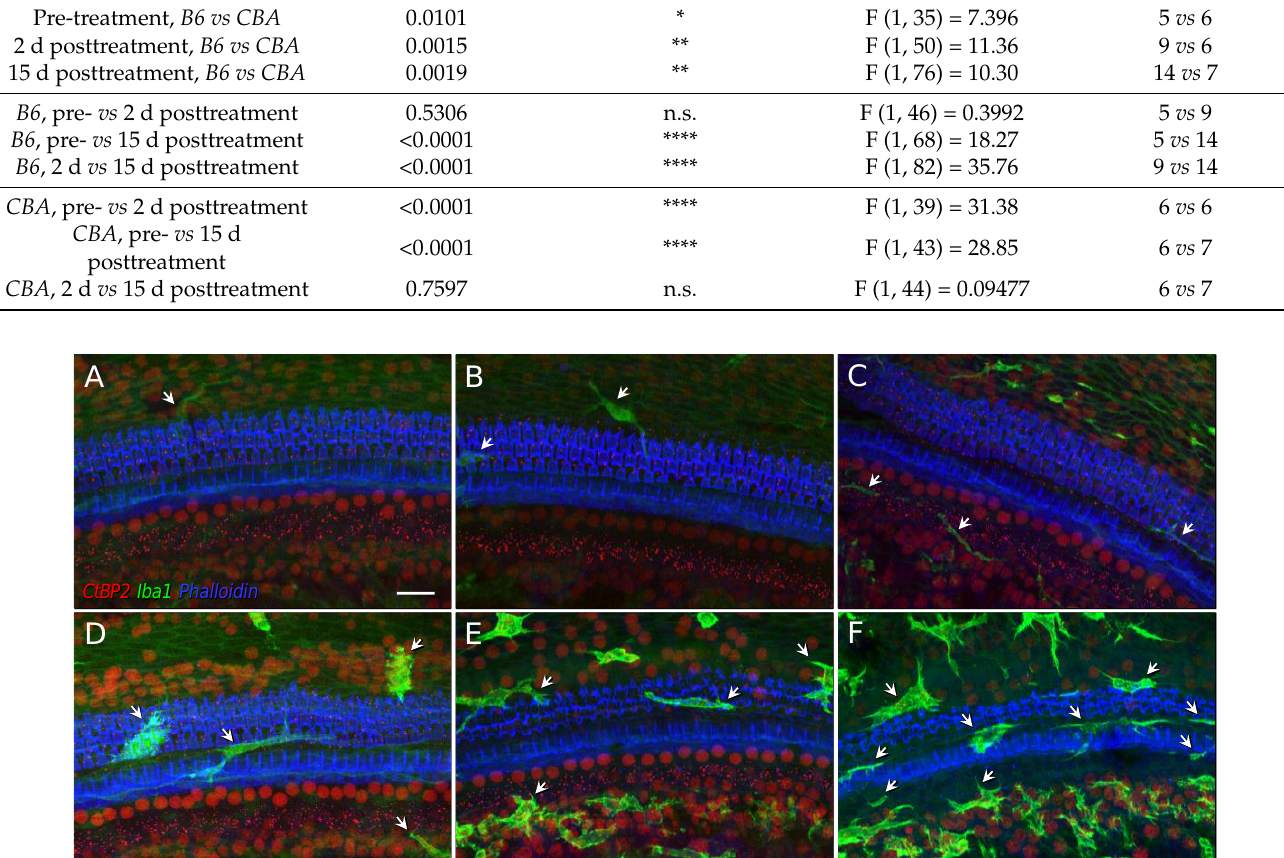
Figure 4. Morphological alteration at the apical-to-middle cochlear location after 400 G/200 F treatment. ( A – C ): Complete hair cell survival (blue phalloidin labeling), intact synaptic ribbons (red punctate), and macrophages (green, identified by white arrows) in quiescence were present in confocal z-projection images from individual B6 control mice at the cochlear location corresponding to 12 kHz. Scale bar = 20 µm. Fifteen days after G/F treatment, the degree of hair cell survival varied, from complete OHC survival ( D ), complete OHC loss ( E ), complete hair cell loss including both OHCs and IHCs ( F ). These representative images demonstrate increased macrophage activity in all cases and compromised ribbon synaptic integrity when OHC loss occurred.